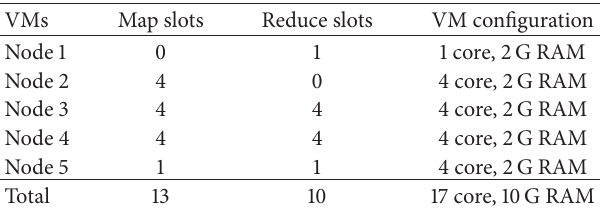
Table 3: Our testbed used in